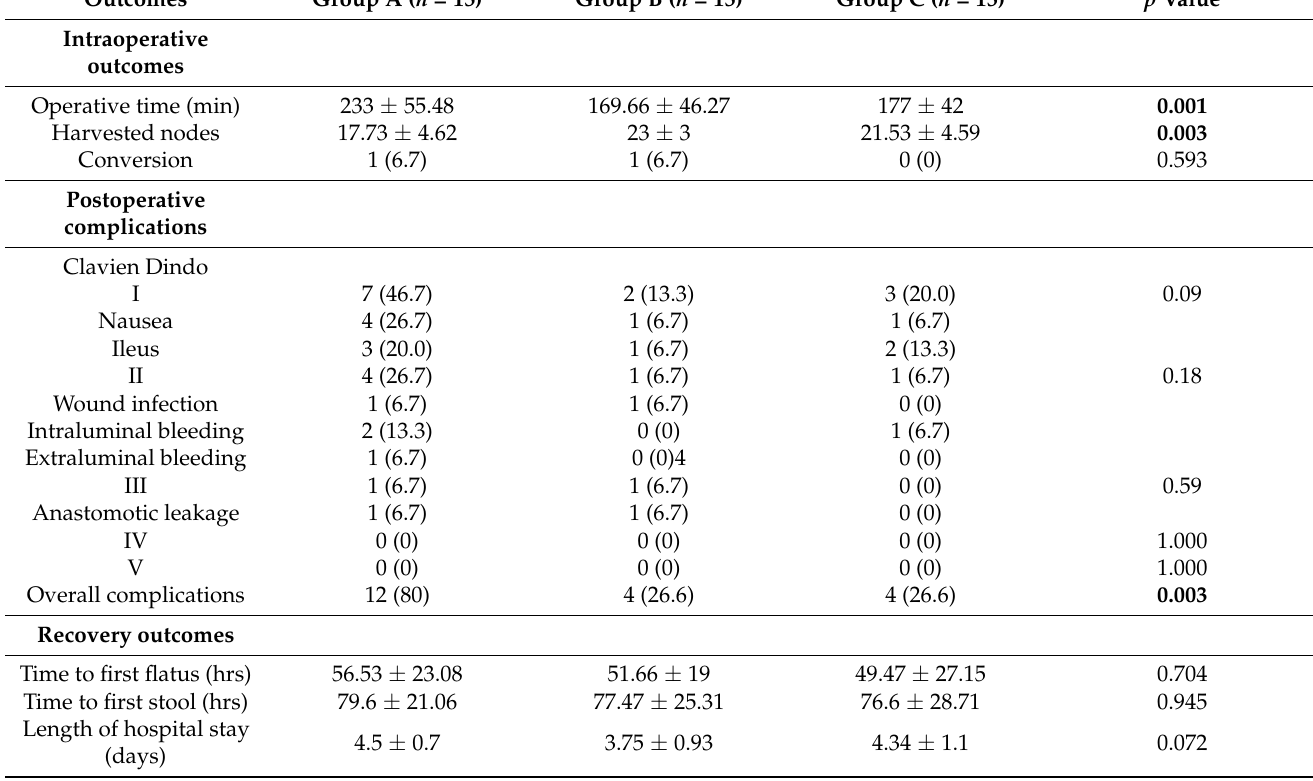
Table 2. Intraoperative outcomes, postoperative complications and recovery